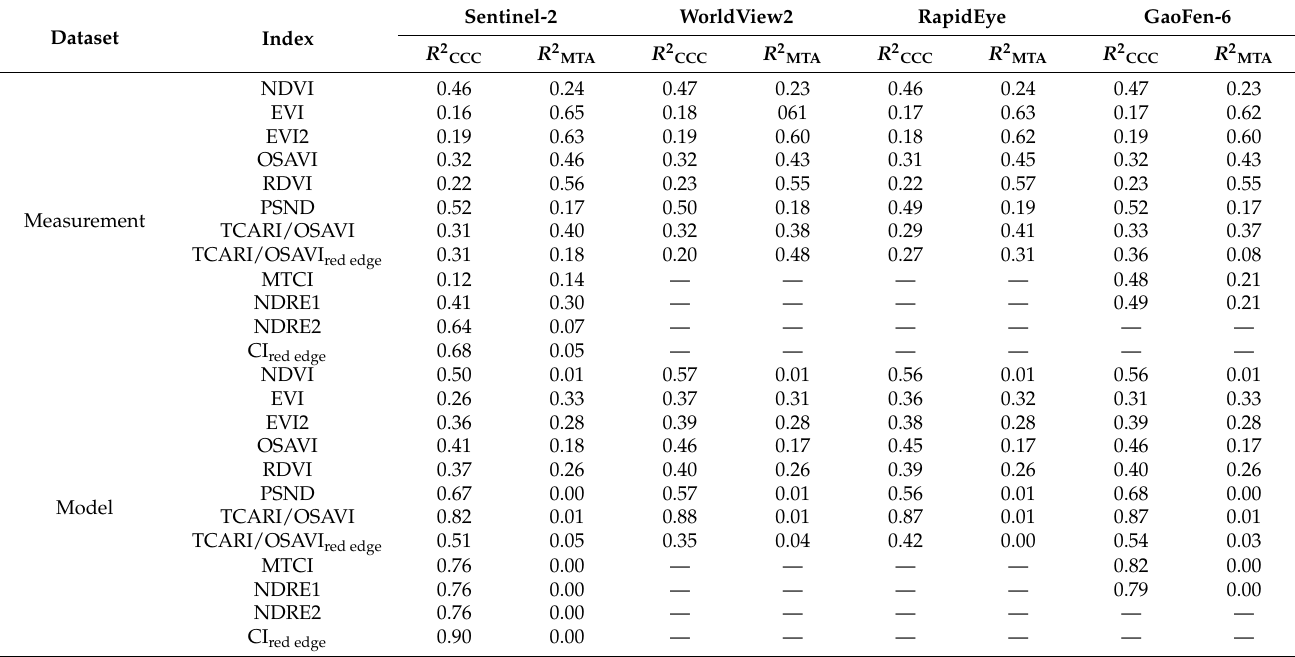
Table 3. Coefficient of determination ( R 2 ) between canopy chlorophyll content (CCC), leaf mean tilt angle (MTA) and tested vegetation indices.